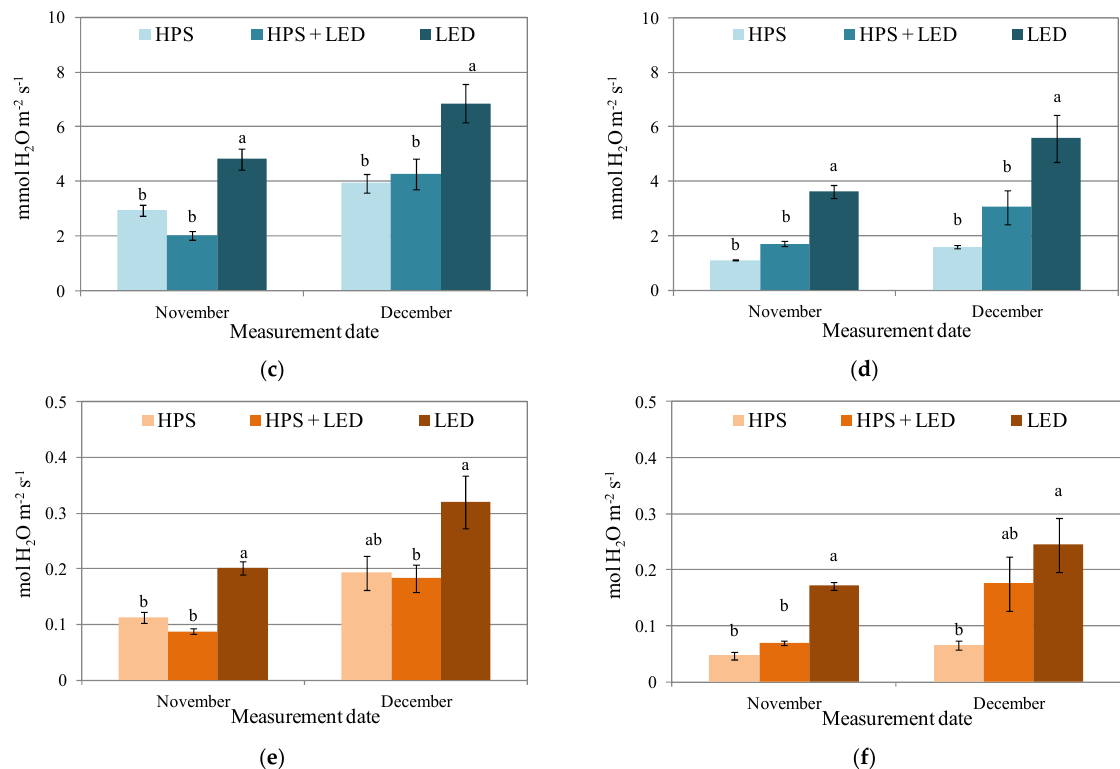
Figure 1. Effect of different light sources (HPS, HPS + LED, LED) on net carbon assimilation (( a ) young leaves, ( b ) old leaves), transpiration rate (( c ) young leaves, ( d ) old leaves) and stomatal conductance (( e ) young leaves, ( f ) old leaves) in cucumber plants. Data are given as mean ± SE, n = 5. Different lowercase letters indicate a significant difference at p < 0.05 using Tukey’s test.